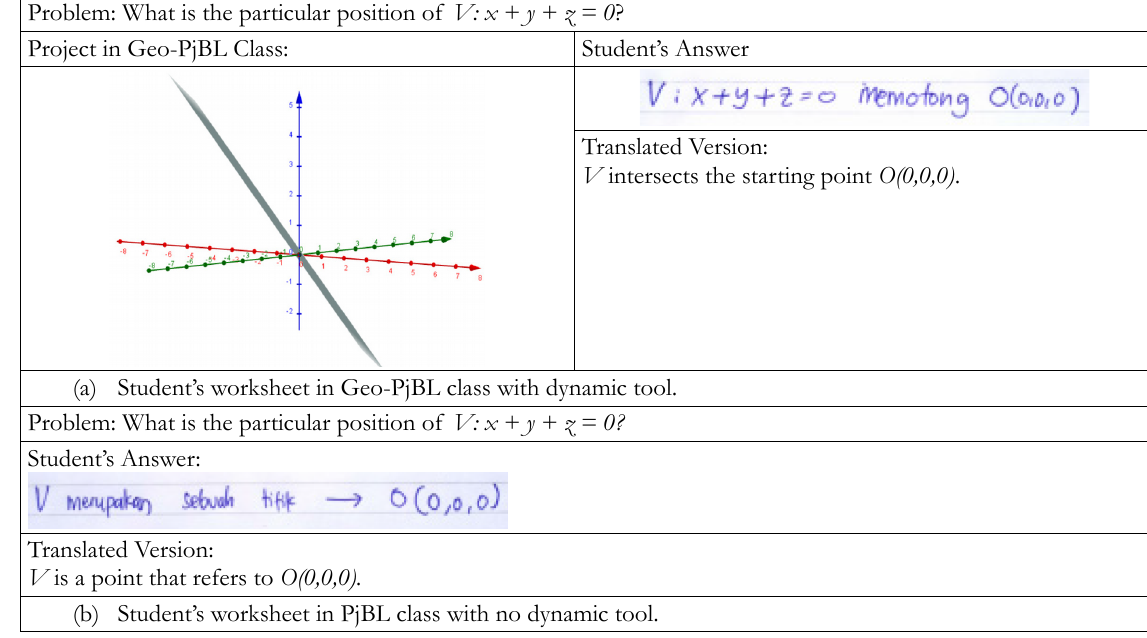
Figure 5. Sample students’